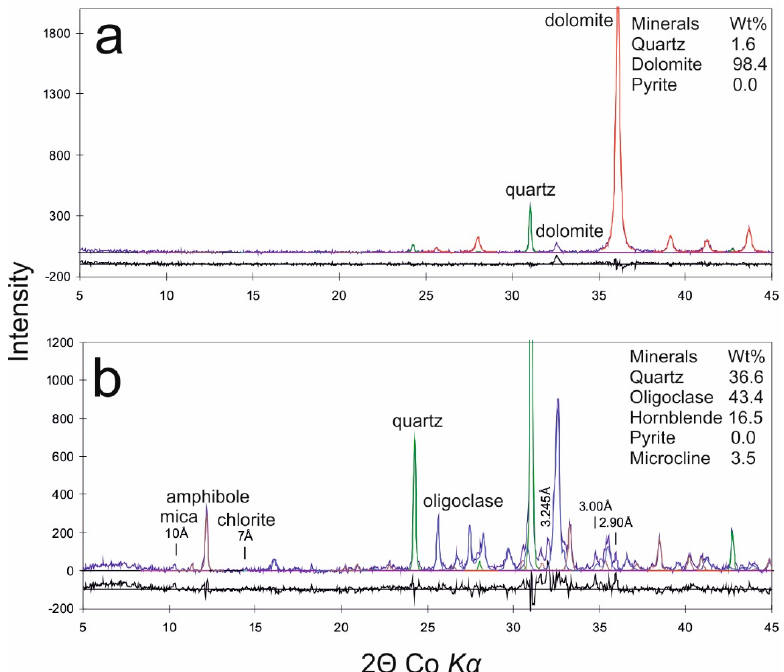
Figure 4. Representative XRD pattern of carbonate rock ( a ) and subsurface sample No. 3 ( b ) (Table 1).